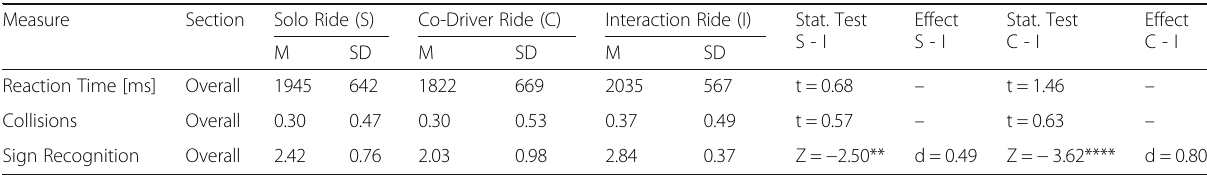
Table 6 Results related to vigilance Measure